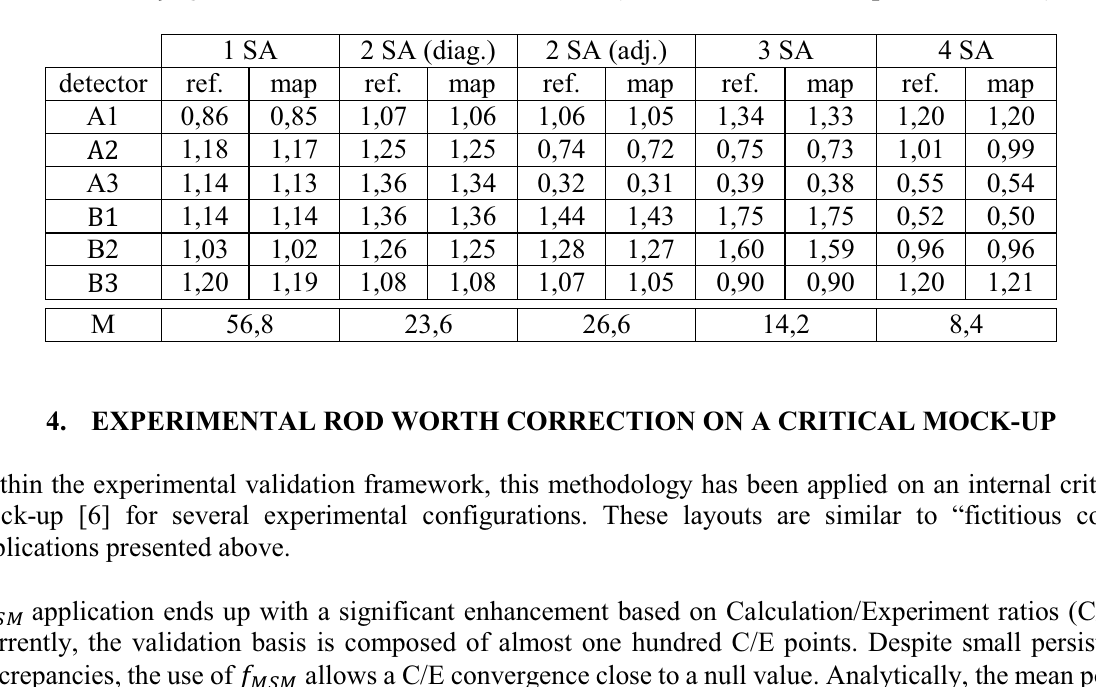
Table IV. * ,-, results for all studied situations (ref. = on counter, map = on